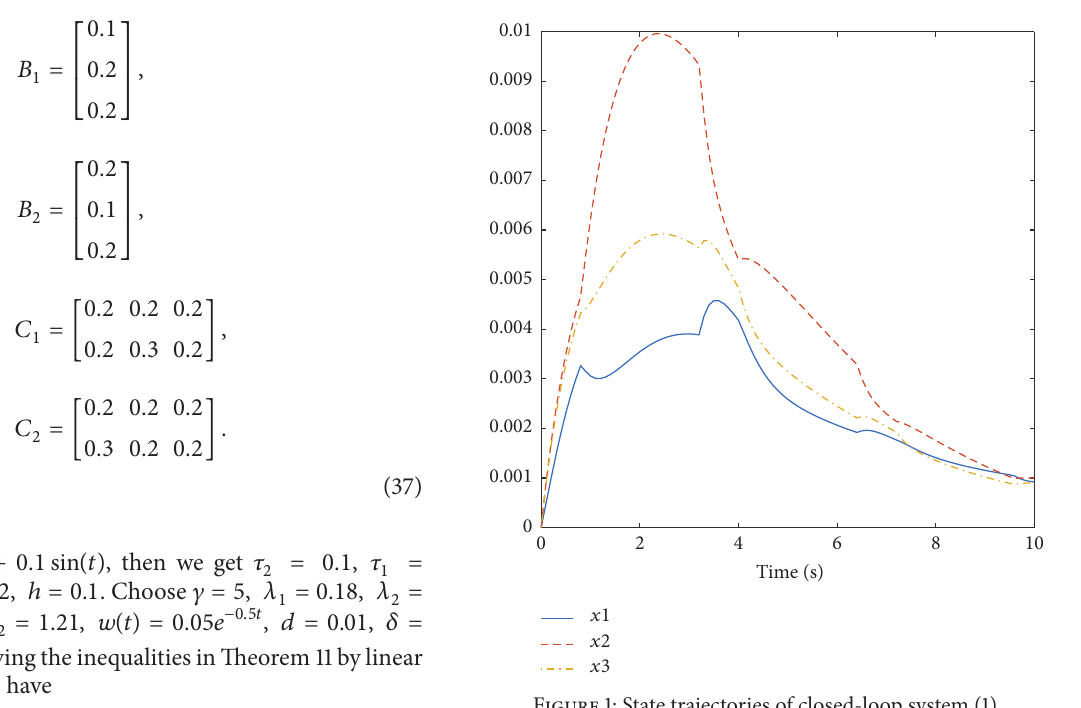
Figure 1: State trajectories of closed-loop system